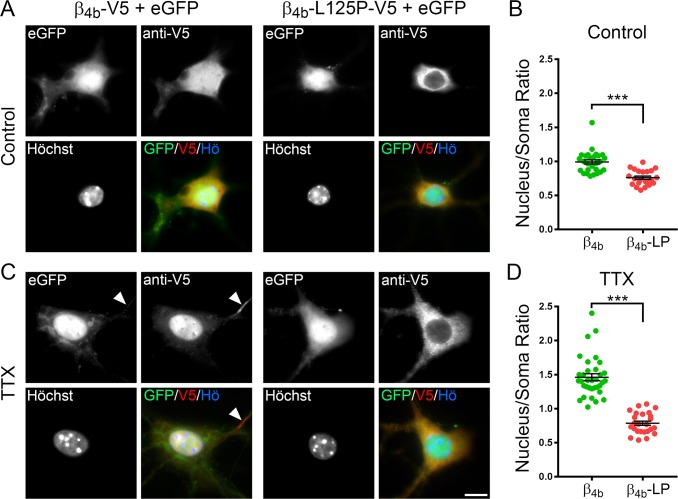
The p.Leu125Pro mutation impairs activity-regulated nuclear targeting of β4b in hippocampal neurons.Cultured hippocampal neurons were transfected with eGFP and β4b-V5 or β4b-L125P-V5 on DIV6 and fixed and fluorescently labeled with anti-V5 (red) and Hoechst dye (blue) on DIV34 (control) or DIV35 (TTX). TTX treatment (1μM) was performed overnight (12h). (A) In untreated neurons (control) β4b-V5 was distributed throughout the soma, dendrites and axons (not visualized) and, to a low degree, also in the nucleus. In contrast, localization of β4b-L125P-V5 was more strongly restricted to the cell soma and largely excluded from the nucleus. (B) Nucleus/cytoplasm ratio of anti-V5 labeling intensity. (C) Overnight silencing of electrical activity with TTX induced a strong accumulation of β4b-V5 in the cell nuclei while β4b-L125P-V5 failed to localize to the nucleus. Note that wild-type β4b-V5 (but not β4b-L125P-V5) also accumulated in the axon hillock (arrowhead, see Results for statistics). (D) Nucleus/cytoplasm ratio of β4b-V5 and β4b-L125P-V5. Statistics (B and D), 2-way ANOVA: Transfection: F(1, 104) = 166, P < 0.001; treatment (control, TTX): F(1, 104) = 35, P < 0.001; transfection x treatment: F(1, 104) = 27, P < 0.001; Holm-Sidak posthoc analyses showed P < 0.001 (***) in all pairwise comparisons except for treatment (TTX, control) within β4b-L125P (P = 0.64). A total number of 108 cells (between 22 and 34 in each treatment group) from two separate culture preparations was analyzed. Scale bar, 10 μm.